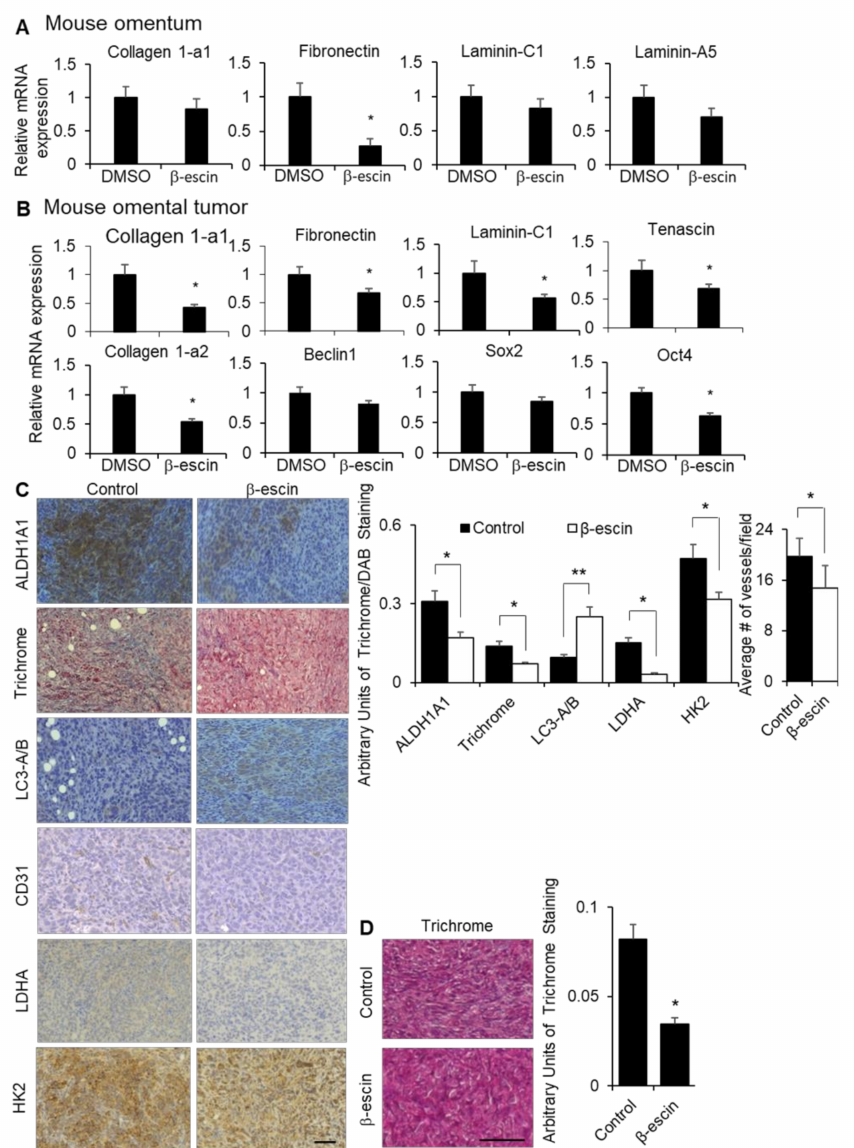
Figure 6. β -escin treatment inhibits extracellular matrices and HIF1 α targets in vivo. ( A ) Fibronectin, collagen 1-a1, laminin-C1, and laminin-A5 mRNA expressions were measured by qRT-PCR in mouse omentum after the mice were treated with β -escin (5 mg/kg/day) for 14 days. ( B , C ) Tumors were collected from the syngeneic in vivo intervention study. Twenty-eight days after the intraperitoneal injection of ID8 mouse ovarian cancer cells, C57Bl/6 mice were given water ad libitum with β -escin (3 mg/kg/day) or DMSO (50 µ L equal volume) in 500 mL of the total volume, and were sacrificed 21 days later when the omental tumor was collected. ( B ) Fibronectin, collagen 1-a1, fibronectin, laminin-C1, tenascin, collagen 1a-2, Beclin1, Sox2, and Oct4 mRNA expressions were measured by qRT-PCR in the mouse omental tumors. ( C ) ALDH1A1, LC3B, LDHA, and HK2 expression levels and the number of vessels (CD31+) were detected by immunohistochemical analyses, while the collagen fibers were stained with trichrome stain (blue) in cross-sections of omental tumors (mean ± SD). *, p < 0.05. line, 100 µ m. ( D ) Twenty-eight days after the intraperitoneal injection of ID8 mouse ovarian cancer cells, C57Bl/6 mice were given water ad libitum with β -escin (1 mg/kg/day) or DMSO (50 µ L equal volume) in 500 mL total volume, and were sacrificed 14 days later when the bowel tumor was collected. The collagen fibers were stained with trichrome stain (blue) in cross-sections of the bowel tumors (mean ± SD). *, p < 0.05. **, p < 0.01. line, 100 µ